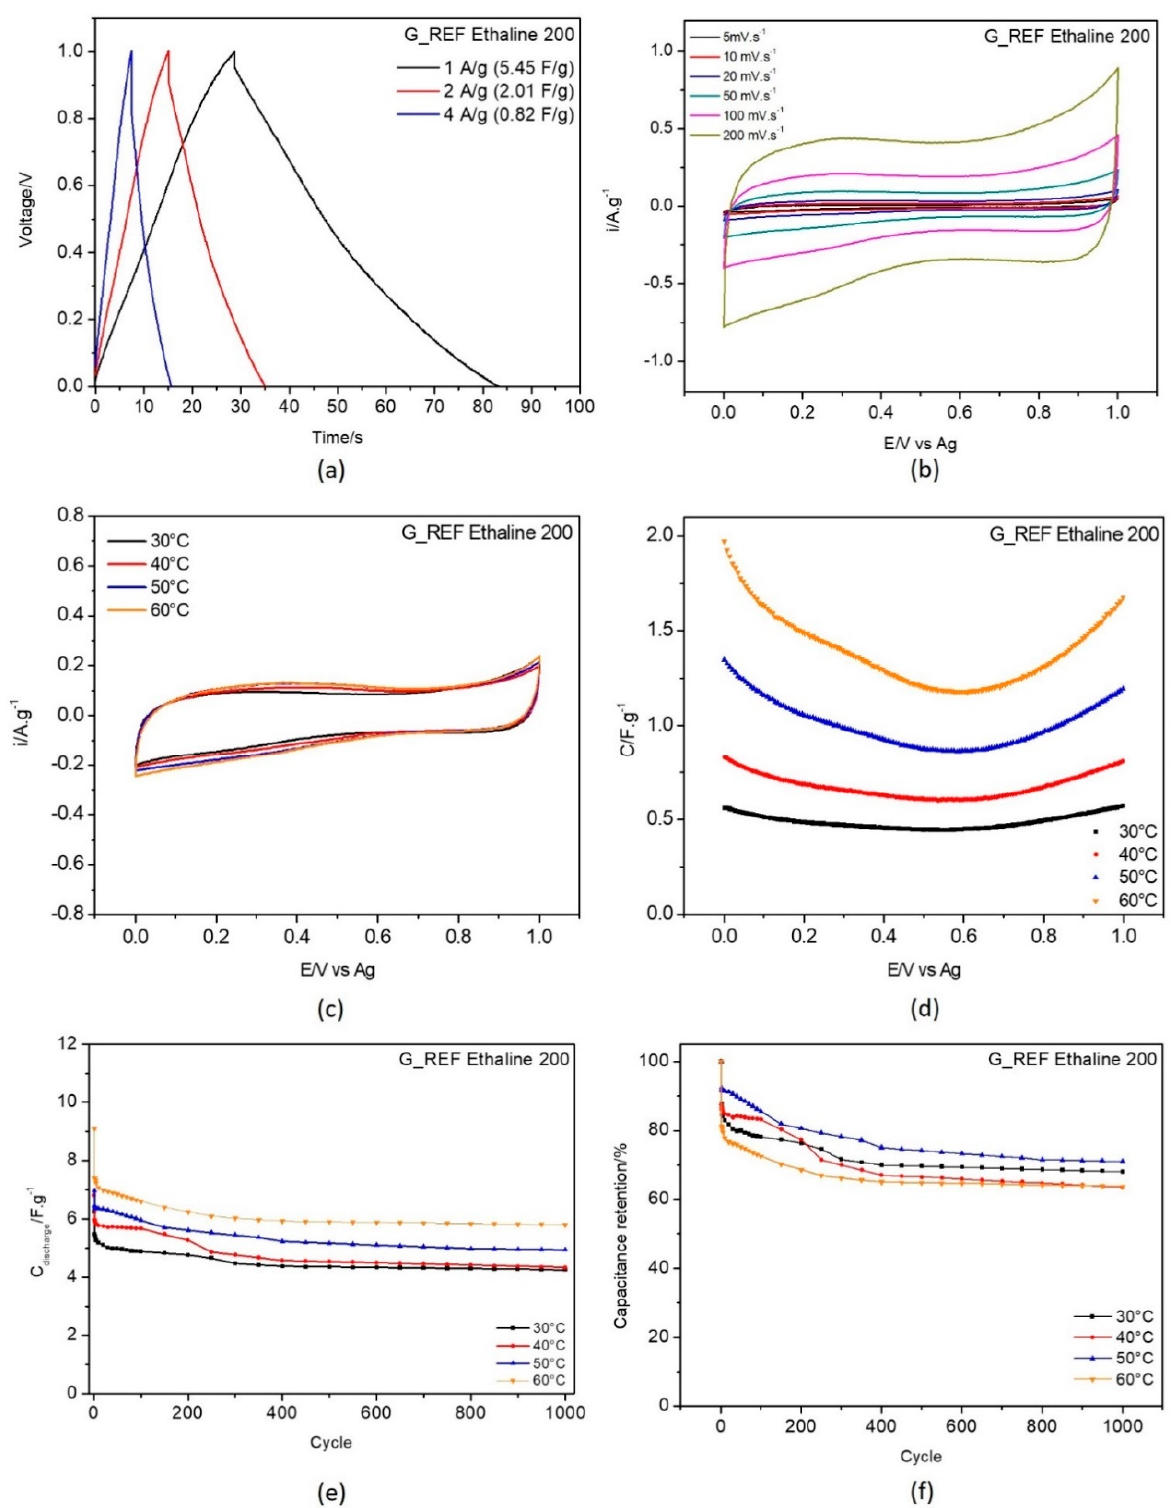
Figure 6. Electrochemical testing of G_REF in E200 electrolyte: ( a ) galvanostatic charge − discharge curves recorded with current density 1, 2 and 4 A·g − 1 at 30 °C; ( b ) CV curves recorded at scan rates 5, 10, 20, 50, 100 and 200 mV·s − 1 at 30 °C, temperature effect on ( c ) cyclic voltammetry at 50 mV.s − 1 ; ( d ) capacitance − potential curve; ( e ) discharge gravimetric capacitance for 1000 cycles; and ( f ) capacitance retention.